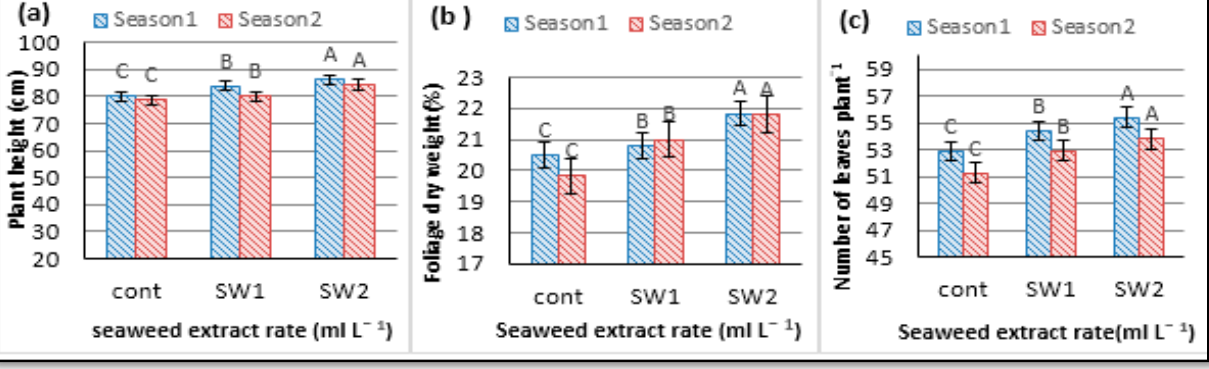
Figure 2. Vegetative growth parameters (means ± SE) of globe artichoke as affected by the application of seaweed extract rate (Control: without, SW 1 : 5 and SW 2 : 10 mL L − 1 ) on ( a ) Plant height (cm); ( b ) Foliage dry weight (%) and ( c ) Number of leaves plant − 1 . Letters in the figures indicate that the mean ± SE treatments with the same letters were not significantly different according to Duncan’s multiple range test for p < 0.05.